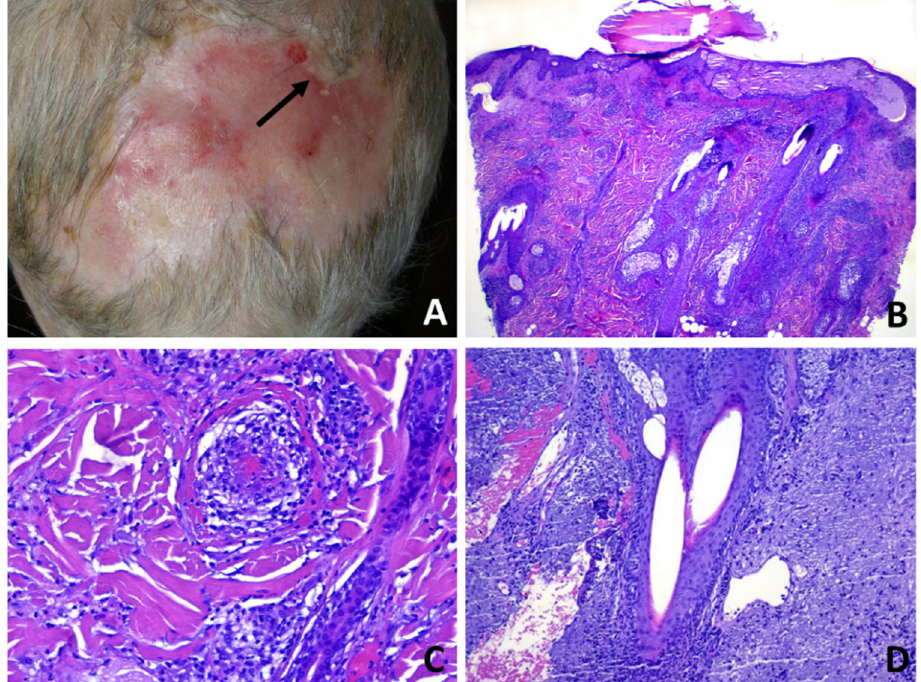
Figure 5. Erosive pustular dermatosis of the scalp; ( A ) scarring alopecia and erosions with presence of follicular pustules, lakes of pus and tufted hairs at the expanding margins (arrow); ( B ) multiple adjacent infundibula showing intrafollicular and perifollicular suppuration; ( C ) perivascular infiltrate of neutrophils with hints of vasculitis. The confluence of multiple vesiculo-pustules at intraepidermal level results into an intraepidermal blister; ( D ) two follicles converge toward a common opening above the entrance of the sebaceous duct.